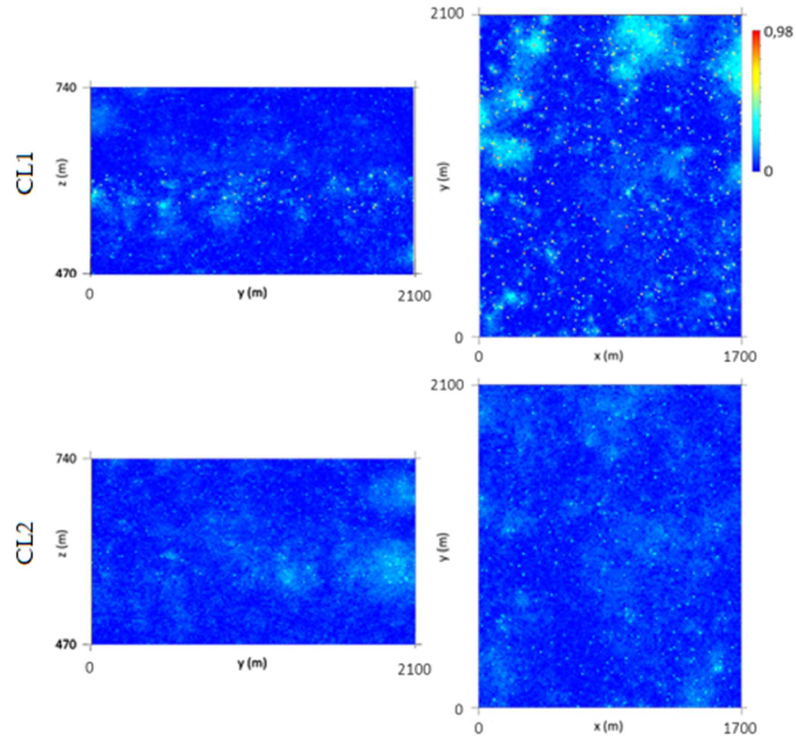
Figure 12. Direct Sequential Simulation results for CL1 and CL2: Px81 ( left ) and Pz75 ( right ). The diagrams show 1 of 200 scenarios.